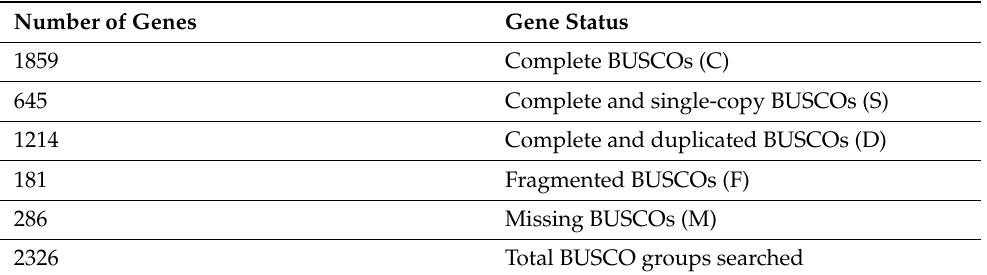
Table 4. BUSCO analysis of Platanus k96 assembly using a database of eudicot-specific genes. BUSCO v. 5.2.2. The lineage dataset is: eudicots_odb10 (Creation date: 10 September 2020,